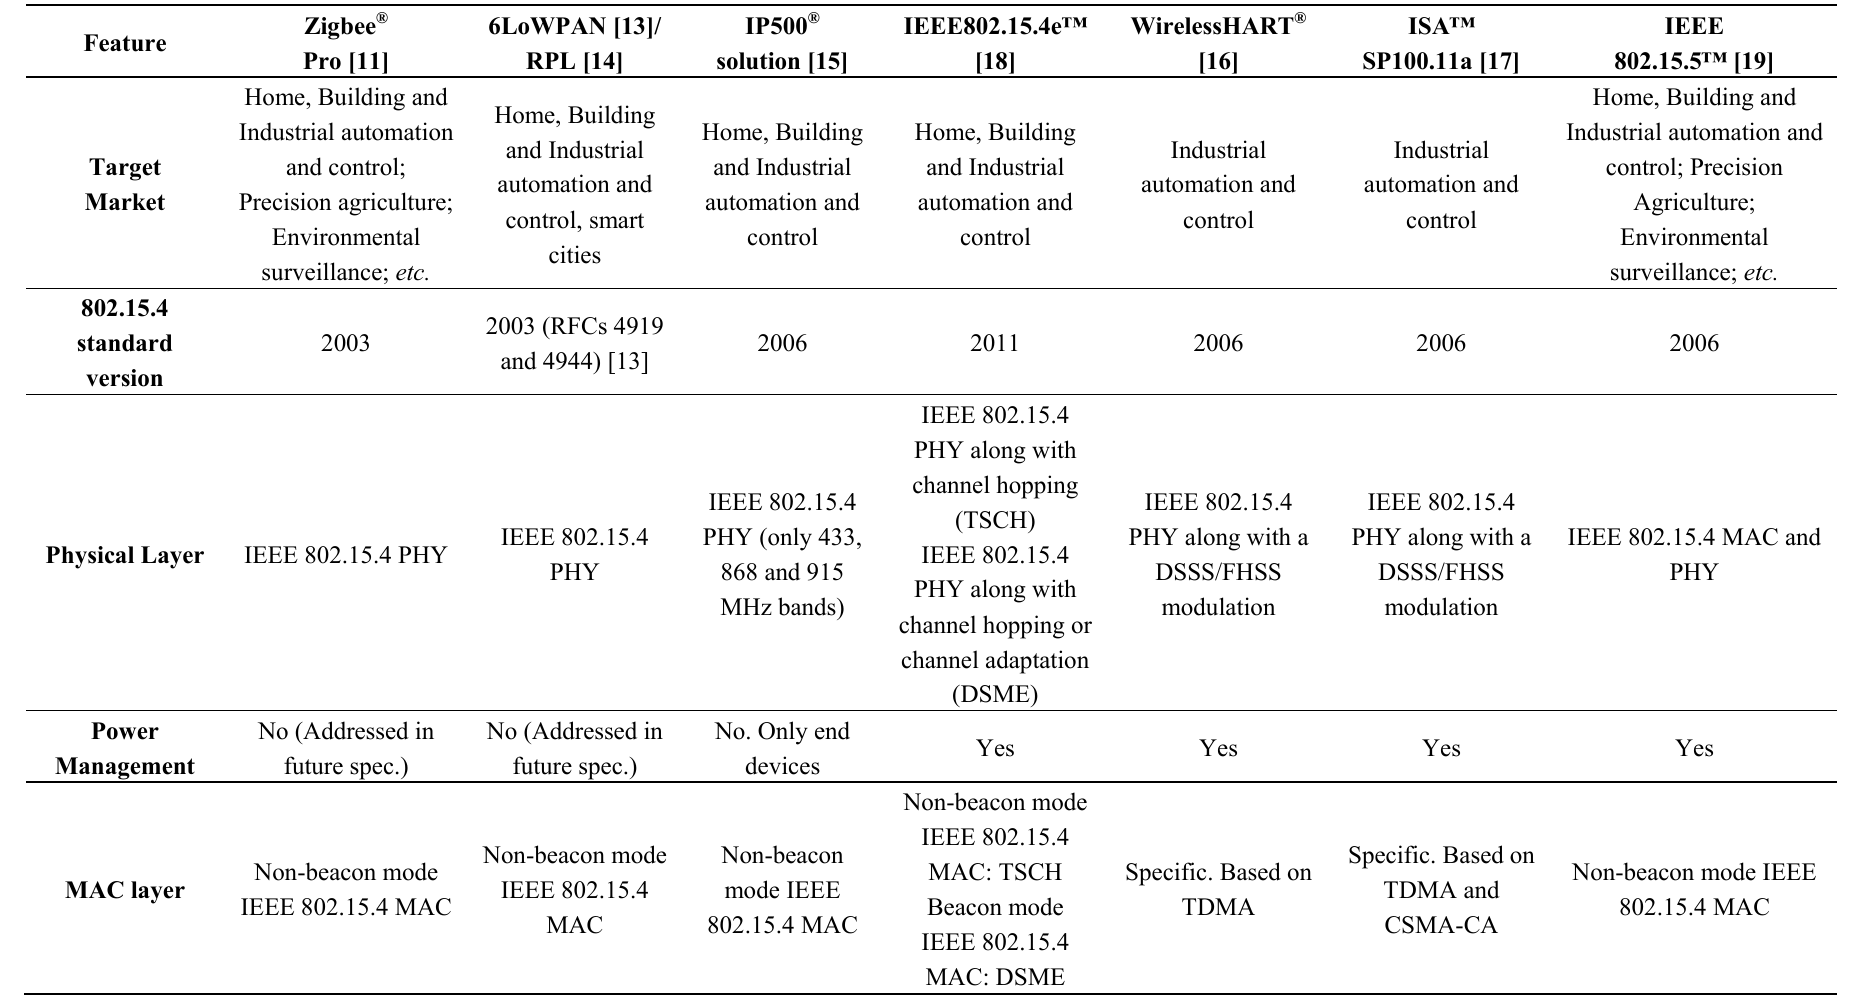
Table 1. Main features of current wireless mesh sensor network